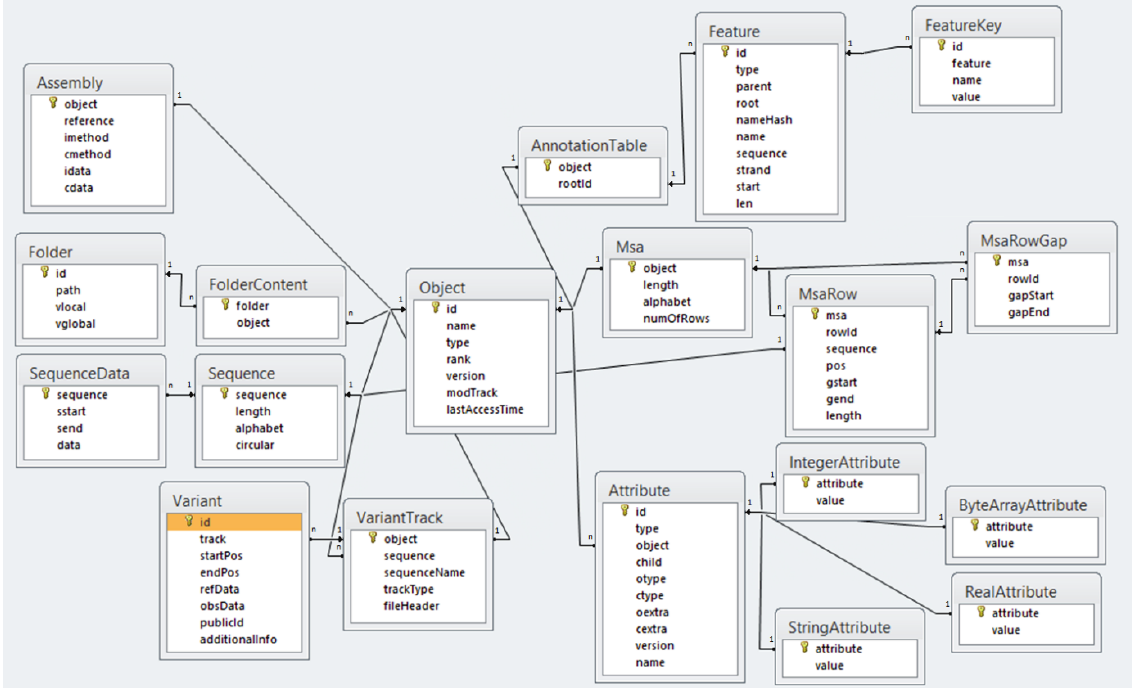
Figure 2: ER-diagram of the shared data storage for “complex” data types. The central entity here is a record in the “Object” relation. It serves for the storage of common attributes of biological objects including name and data type. Depending on a particular object type, its data are stored in different relations. For example, sequence objects are stored in one way, whereas annotations (or features) are considered to be separate objects and stored in another way. In addition, there are relations for arbitrary key-value attributes of any object type (for example, an accession number for a sequence) – common “Attribute” relation and a few value-dependent relations that keep values for each record from the “Attribute”